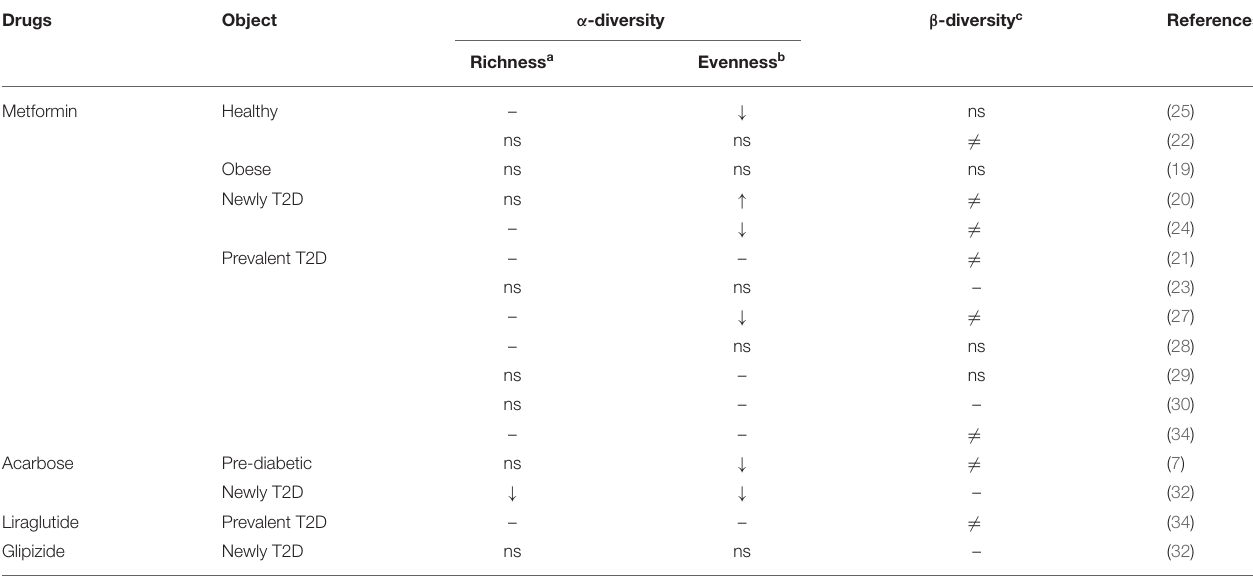
TABLE 8 | Effects of anti-hyperglycemic drug on diversity of human gut